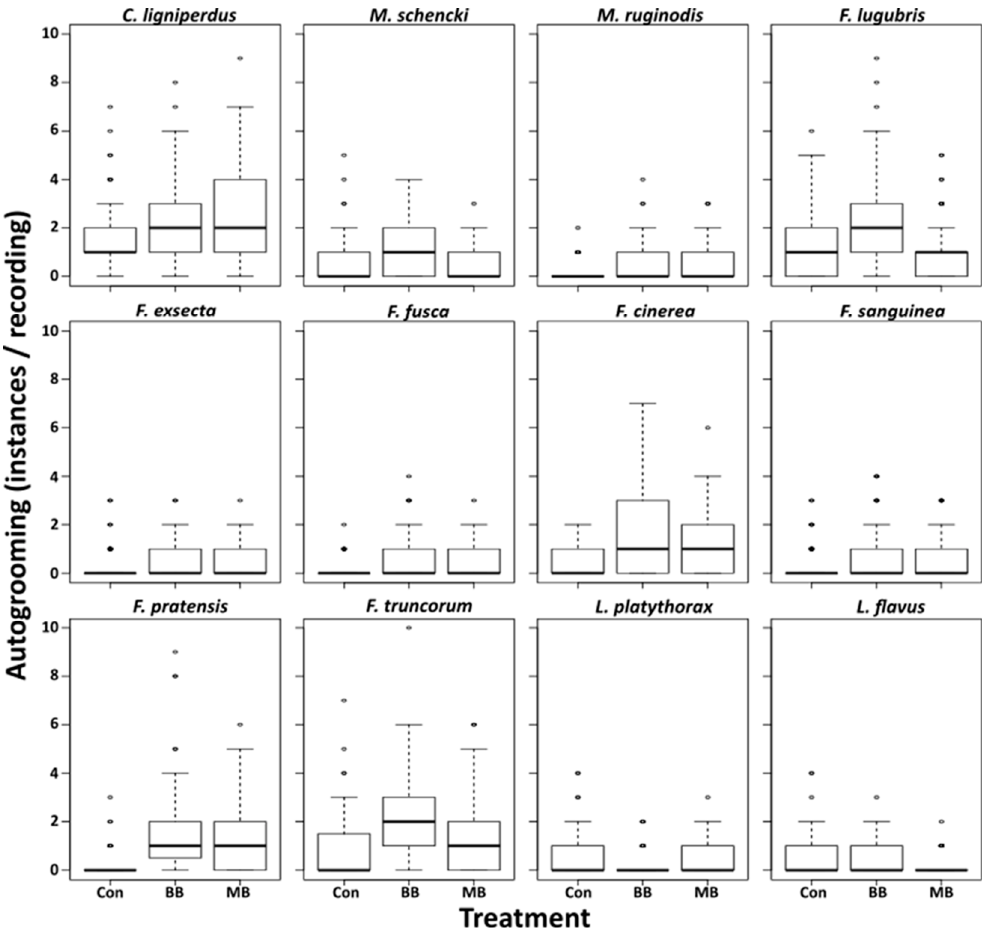
Figure 2. Autogrooming rates. Behavioral comparisons between control ants (Con), ants exposed to B . bassiana (BB), and ants exposed to M. brunneum (MB).